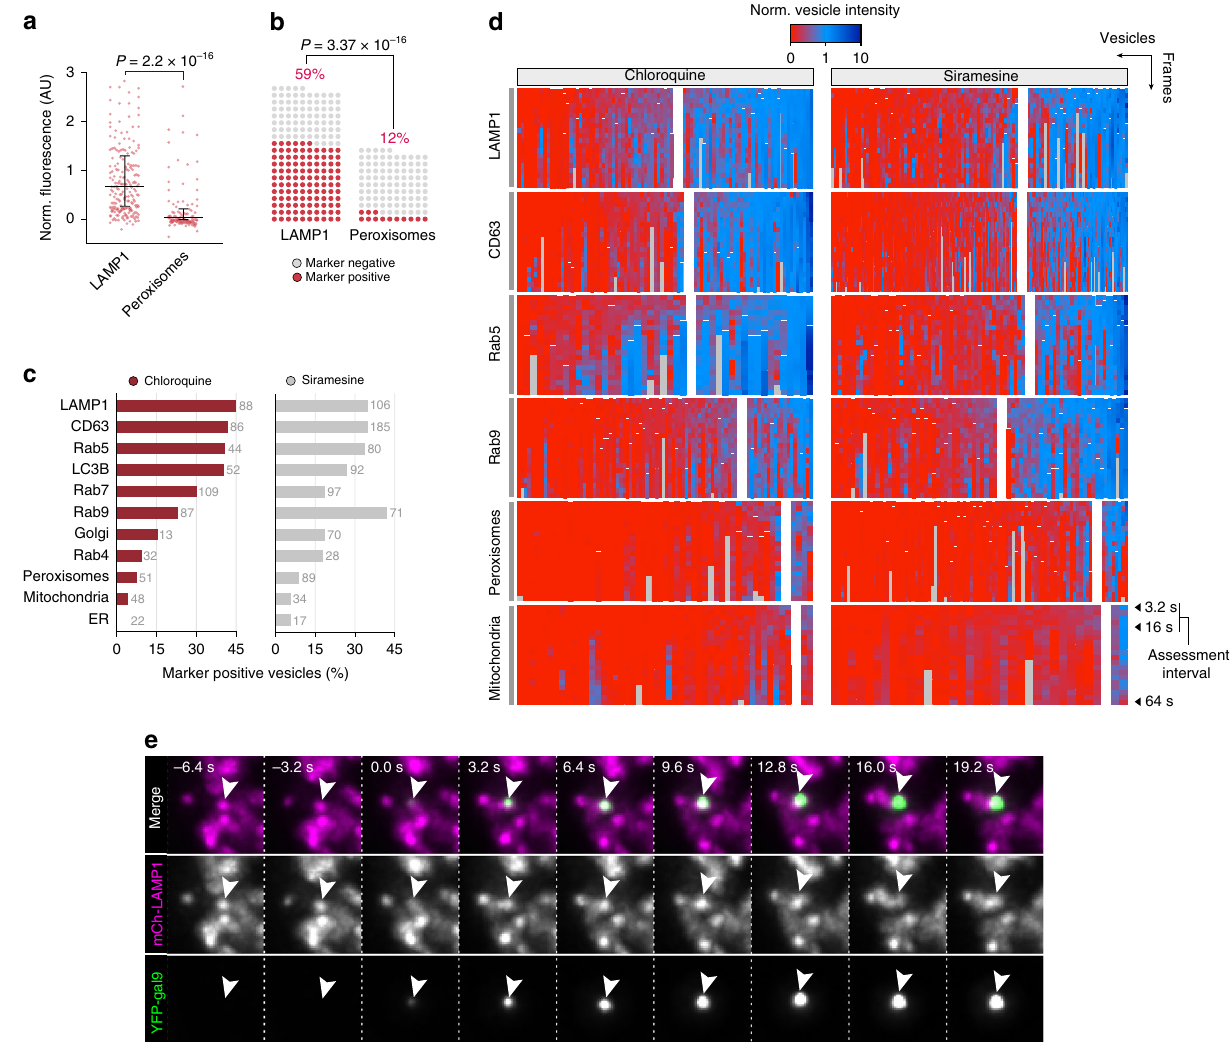
Fig. 6 Mapping the compartment identity of disrupted vesicles. HeLa cells expressing YFP – galectin-9 and a mCherry-tagged endosome or organelle marker were treated with membrane disruptive small molecules during wide fi eld live-cell microscopy. De novo induced galectin foci were tracked in 4D, and the marker fl uorescence intensity of damaged objects were evaluated between ∼ 3 and 16 s after detectable galectin recruitment. a , b Evaluation of galectin-9 + vesicles in cells expressing either mCherry-tagged LAMP1 or a peroxisome marker, treated with 1 mM LLOMe. N = 195 and 105 vesicles from two independent experiments. a Mean intensity of endosomal markers on single vesicles are shown, with median and interquartile range indicated by bars. Two-tailed Mann – Whitney test. b Fraction of damaged vesicles classi fi ed as positive or negative for the indicated endosomal markers. Two-tailed Fisher ’ s exact test. c Fraction of damaged vesicles with the presence of the indicated endosomal markers. N = evaluated vesicles, indicated next to the bars. At least two independent experiments per condition. d Heatmaps showing the normalized fl uorescence intensity of indicated endosomal and organelle markers on vesicles disrupted by treatment with 60 μ M chloroquine or 10 μ M siramesine. Single-vesicle traces are organized in columns. Rows represent measurements between ∼ 3 and 64 s after detectable galectin-9 recruitment, from top to bottom. Traces were classi fi ed as negative (left subdivisions) or positive (right subdivisions) for the respective endosomal marker, and sorted by the mean initial trace intensity for visualization. N as in c . e Wide fi eld microscopy images showing galectin-9 recruitment to an endosome labeled with mCherry-LAMP1, indicated by the arrows. Images are representative of four independent experiments. Scale bar, 2 μ m. Source data for a – d are presented in a Source Data fi